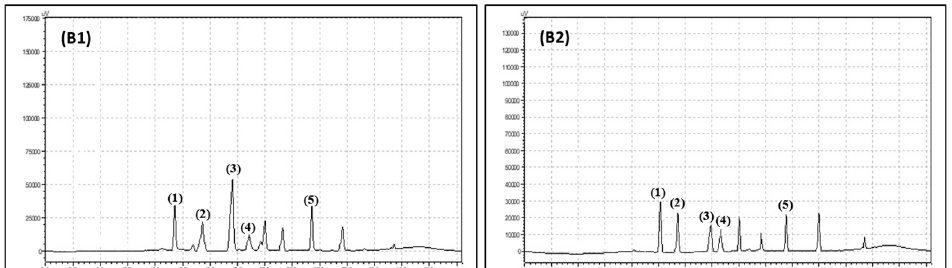
Figure 3. Chromatogram showing retention times for organic raspberry ( B1 ) and conventional raspberry leaves ( B2 ) flavonoids: (1) quercetin-3- O -rutinoside, (2) myrycetin, (3) quercetin-3- O -glucoside, (4) quercetin, (5) luteolin.